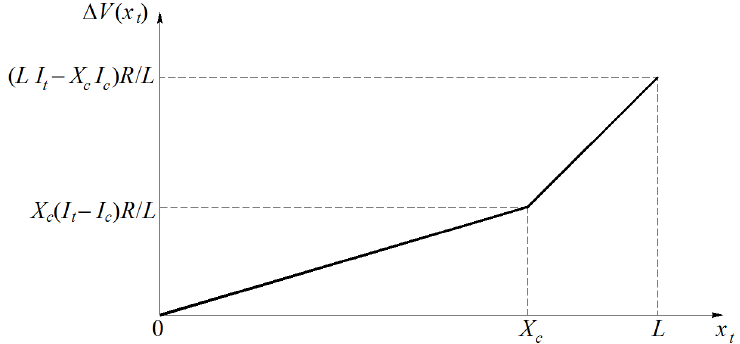
Figure 5. Train’s voltage as a function of its position along the